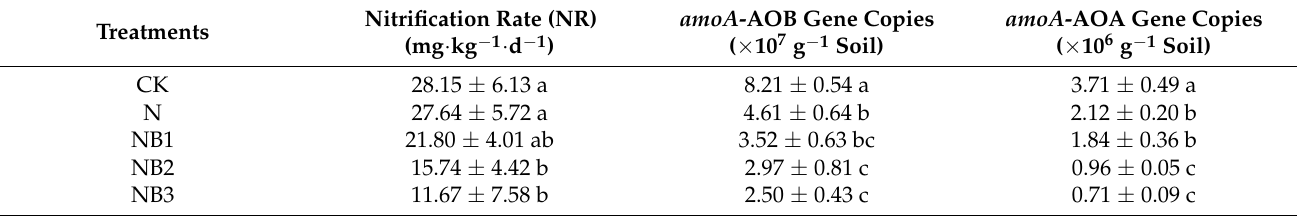
Table 2. Nitrification rate and the numbers of amoA -AOB and amoA -AOA gene copies for all the treatments, plus the one-way ANOVA results with the least significant difference